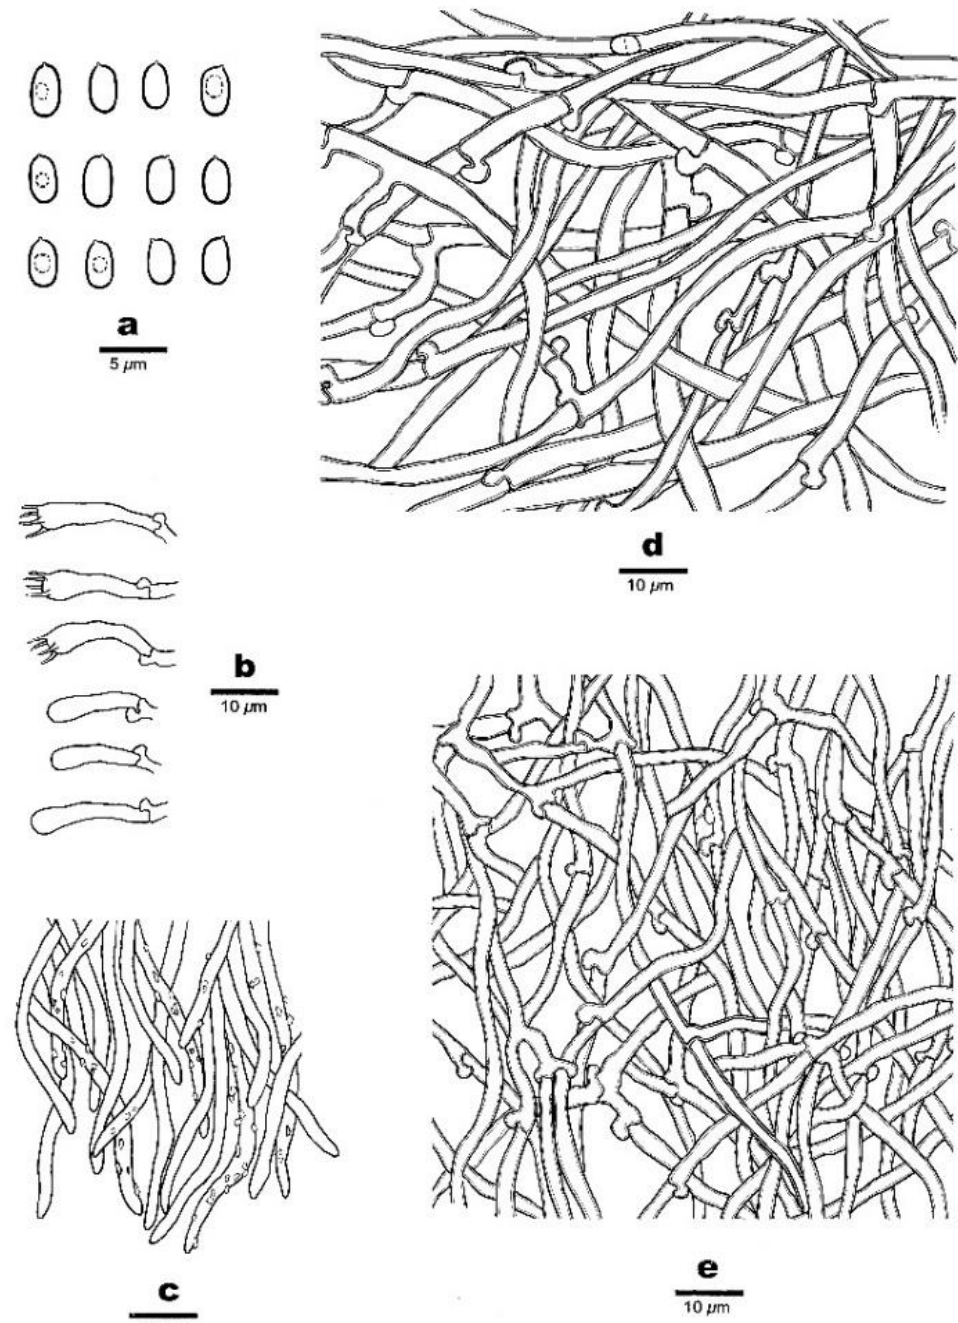
Figure 3. Micro-morphology of Anomoloma denticulatum (Dai 23150). ( a ) Basidiospores. ( b ) Basidia and basidioles. ( c ) Hyphae at dissepiment edge. ( d ) A section of subiculum. ( e ) A section of trama.